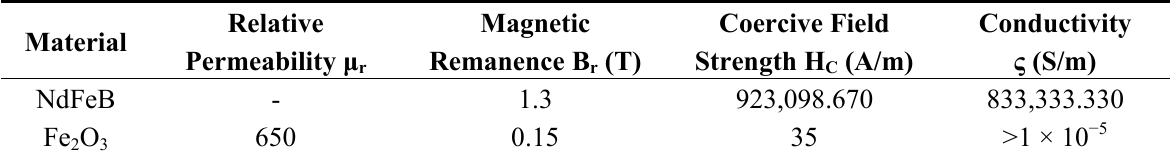
Table 2. Overview of the material properties used for the simulation of the excitation